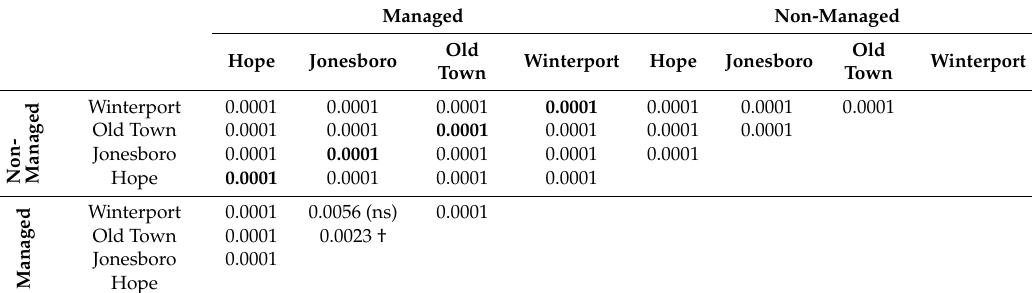
Table 2. Pairwise analysis of molecular variance (AMOVA) comparison between populations currently managed for commercial blueberry production and those from a mature forest not managed for fruit production. p -values are shown (random > data) based on 9999 permutations in GenAlEx 6.5. All populations are significantly different from all others, except Jonesboro managed from Winterport managed when the p -values are Bonferoni corrected. The Old Town managed is different at p ≤ 0.10 (Bonferoni corrected) from the Jonesboro managed. Managed populations are significantly different from their associated paired non-managed population (bold p -values) found in close proximity ( ≤ 500 m).